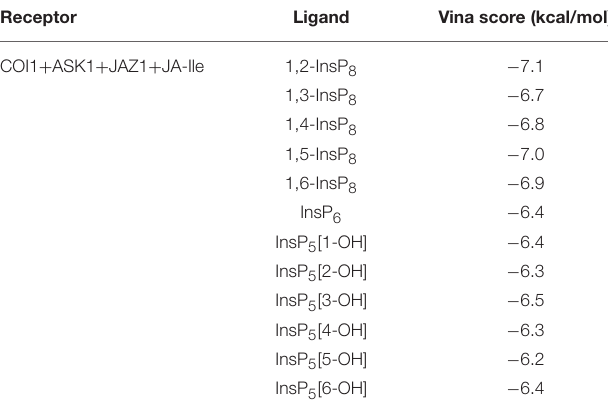
TABLE 2 | Vina score for different forms of InsPs. Receptor Ligand Vina score (kcal/mol)